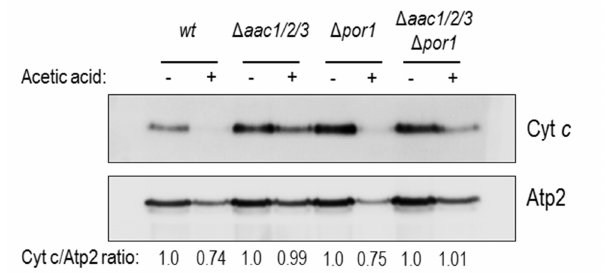
FIGURE 3: Cyt c is released from wt and Δ por1 mitochondria. Cells were pre-cultured in YPD, and then grown O.N. in YPGal until an OD 640nm of 1.5-2.0 was reached, before adding acetic acid. One representative experiment of cyt c immunodetection in wt , Δ aac1/2/3 , Δ por1 , Δ aac1/2/3 Δ por1 mitochondrial fractions, iso- lated from control and acetic-treated cells, is presented. The beta subunit of the F1 sector of mitochondrial F O F 1 ATP synthase (Atp2p) was used as control for the mitochondrial fractions. A densitometric analysis was performed (ImageJ software) and the corresponding cyt c / Atp2 protein ratios are